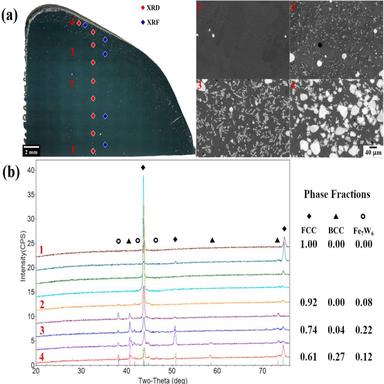
a) Plan view optical and SEM images of the polished compact metallurgical specimen and corresponding b) XRD phase analysis and microstructures of select regions (phase fractions were estimated by greyscale threshold analysis from SEM images).